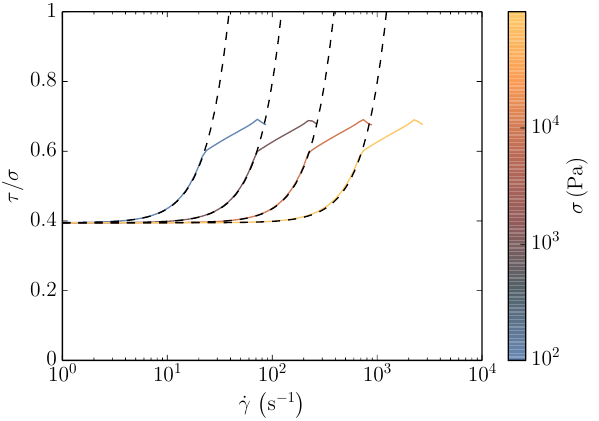
Figure 17. Stress ratio τ/σ according to the extended kinetic theory model (colored solid lines). Material parameters, ν rlp = 0 . 556, ν s = 0 . 581, tan φ (cid:48) ss = 0 . 395, ρ p = 300kgm − 3 , K = 1 . 29 × 10 5 Pam, (cid:15) = 0 . 1, c = 0 . 5, d = 0 . 02m, a = 0 . 2, are chosen to match the simpli- fied friction model (black, dashed lines) with parameters µ = 0 . 395, λ = 0 . 04Pas 2 , χ = 7848m − 1 s − 2 ,